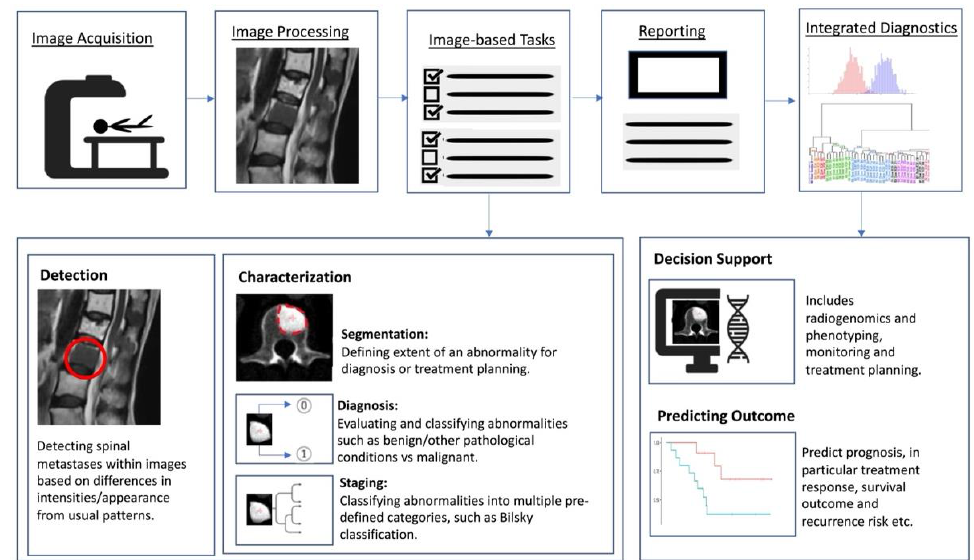
Figure 2. Schematic outline showing where AI implementation can optimise the radiology workflow. The workflow comprises the following steps: image acquisition, image processing, image-based tasks, reporting, and integrated diagnostics. AI can add value to the image-based clinical tasks, including the detection of abnormalities; characterisation of objects in images using segmentation, diagnosis and staging; and integrated diagnostics including decision support for treatment planning and prognosis prediction.